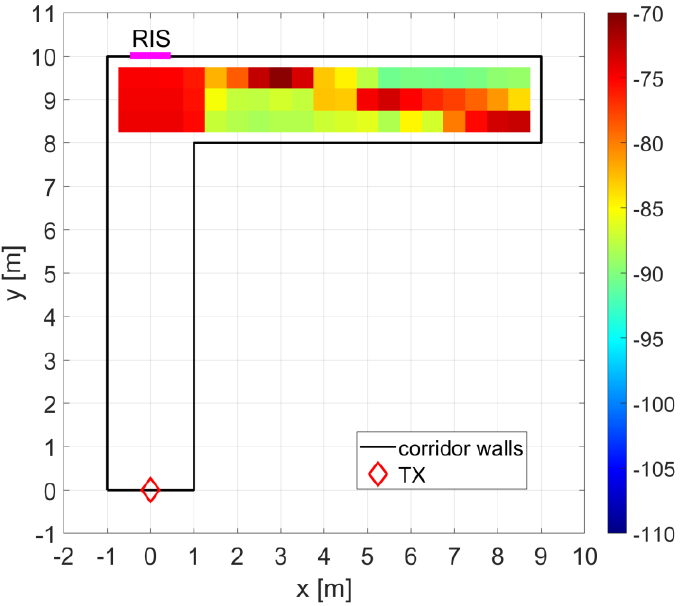
Figure 6. Coverage map in the L − shaped corridor using an RIS reflecting at 80°. Table 1. Parameters of the RIS reradiated modes for different RIS